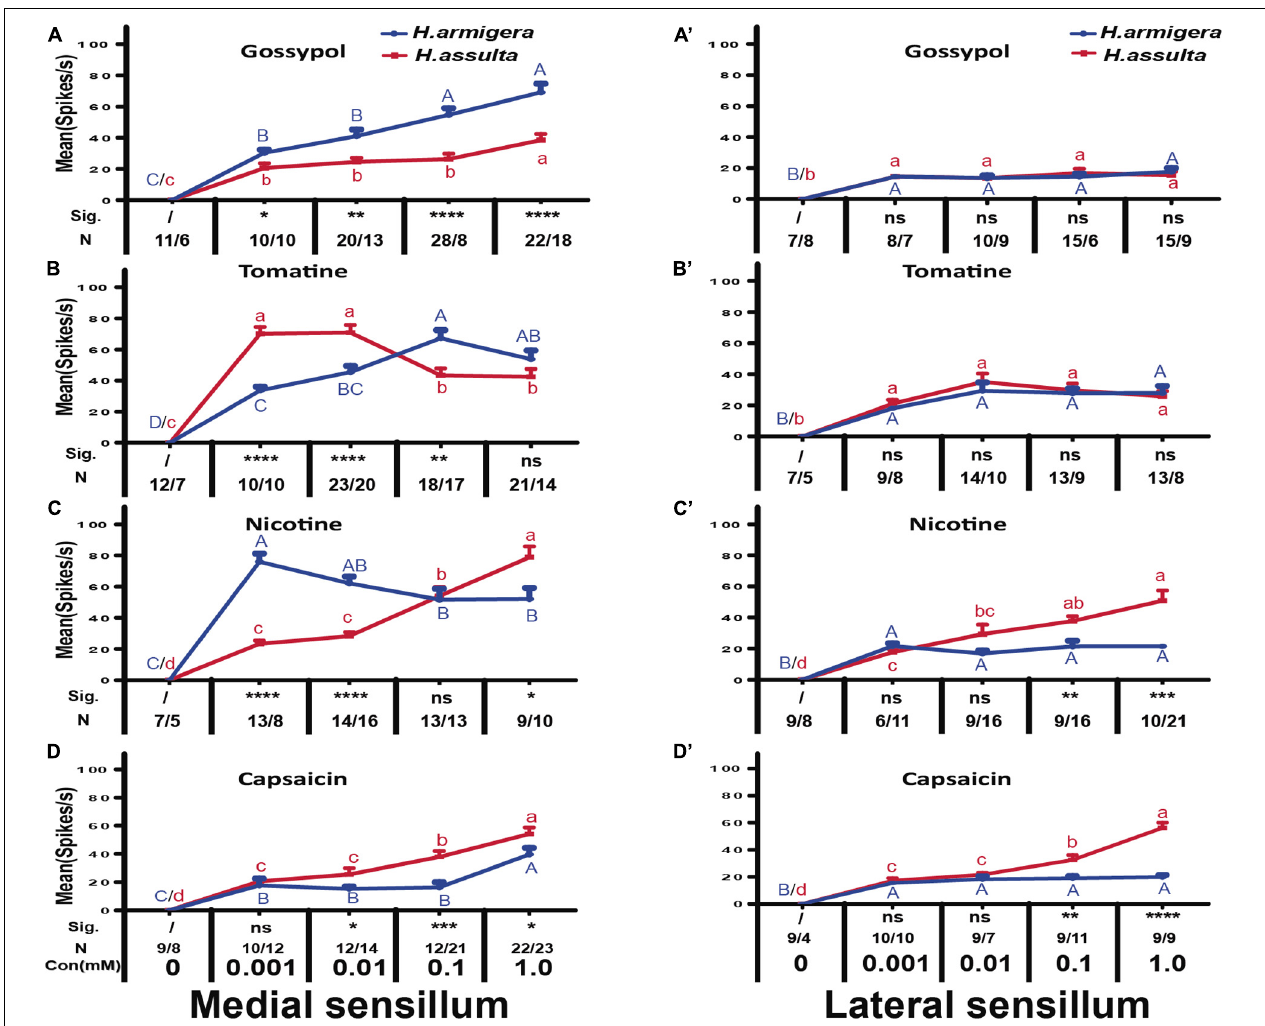
FIGURE 7 | Comparisons of gustatory responses of “M2” GNRs in styloconic sensilla of Helicoverpa caterpillars to different plant secondary metabolites. Curves show the mean responding frequency ± SE of “M2” GNRs in the medial sensillum (A–D) and in the lateral sensillum (A’–D’) of H. armigera and H. assulta caterpillars to secondary metabolites from 0.001 to 1.0 mM. Different capital letters and lowercase letters represent the mean responding frequencies of “M2” GNRs which were significantly different in response to one compound at different concentrations in caterpillars of H. armigera and H. assulta , respectively ( post-hoc SNK test of ANOVA: P < 0.05). Independent t -test was used to compare the difference of the mean responding frequency of “M2” GNRs to the same compound at the same concentration between the two Helicoverpa species. “Sig.” represents the levels of difference. “ns”: no significant different ( P > 0.05); “*,” “**,” “***,” and “****” represent that the difference was significant at the 0.05, 0.01, 0.001, and 0.0001 levels, respectively. “N” represents the number of tested caterpillars of H. armigera / H. assulta .